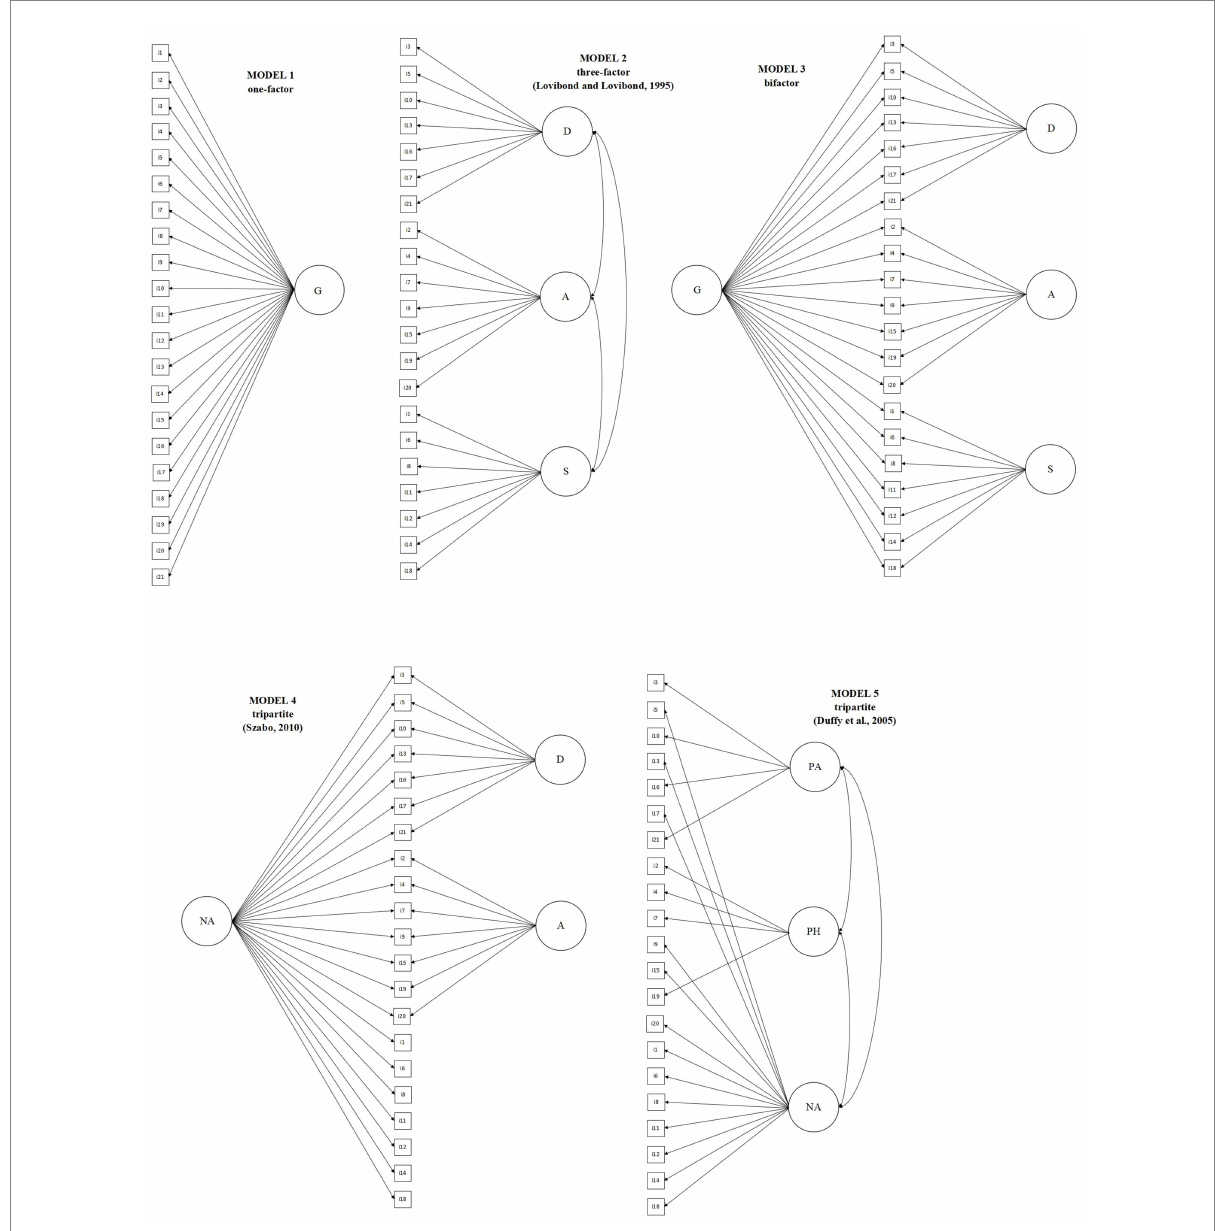
FIGURE 1 Five alternative models of the DASS-21 evaluated in the